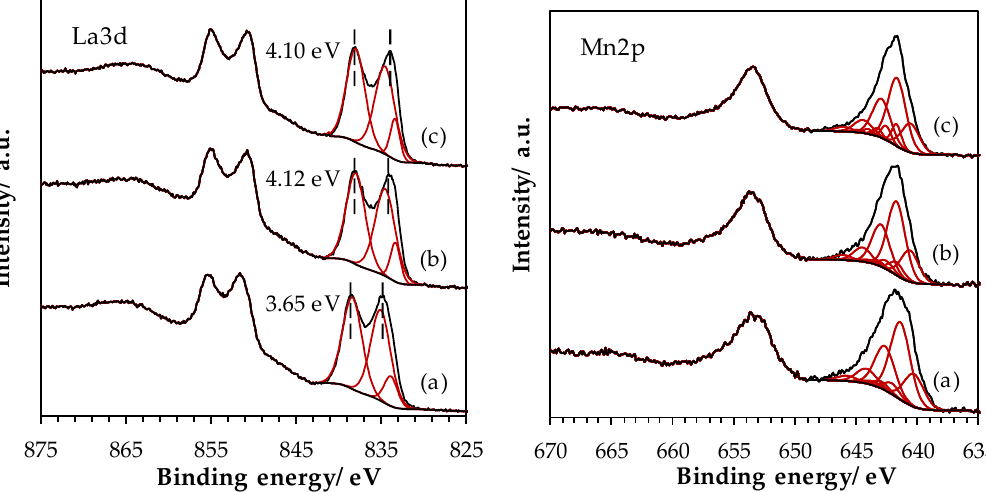
Figure A1. High-resolution spectra of La 3d and Mn 2p core level spectra for LaMnO 3.15 samples: (a) SSR, solid state reaction; (b) HEBM, high-energy ball milling; (c) LEBM, low-energy ball milling.